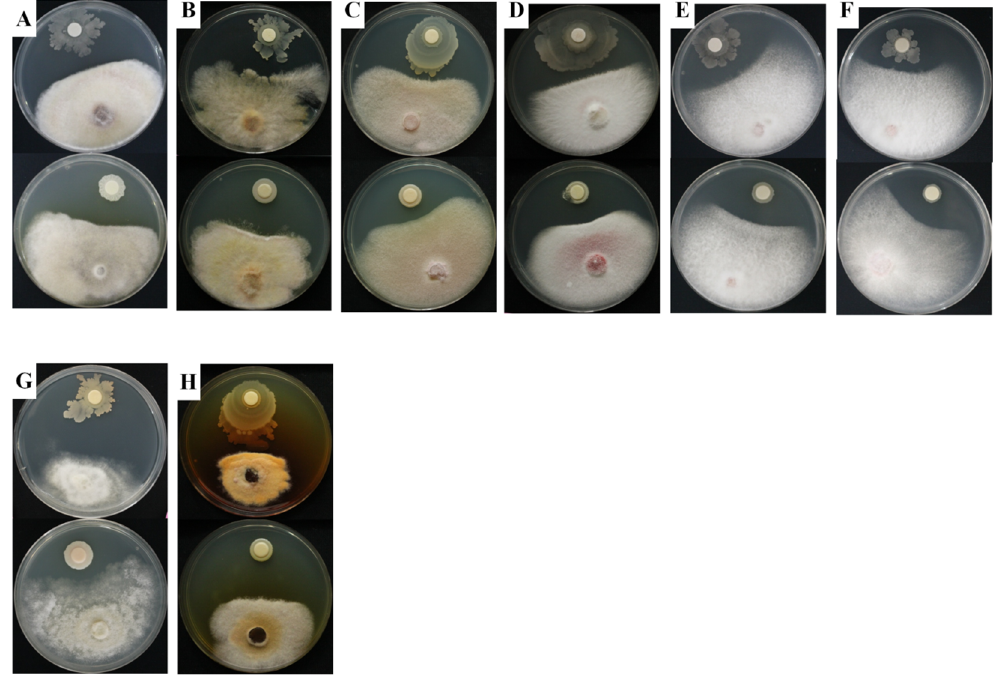
Figure 5. In vitro antifungal activity of the isolated Burkholederia strains against different phytopathogens in the dual culture: ( A ) A. alternate , ( B ) F. graminearum , ( C ) F. moniliforme , ( D ) F. ( D ) F. oxysporum f.sp. melonis , ( E ) F. subglutinans, ( F ) F. temperatum , ( G ) P. drechsleri , and ( H ) S. lycopersici oxysporum f.sp. melonis , ( E ) F. subglutinans , ( F ) F. temperatum, ( G ) P. drechsleri , and ( H ) S. lycopersici (top = B. cenocepacia strain KNUBI2, bottom = B. contaminans strain (top = B. cenocepacia strain KNUBI2, bottom = B. contaminans strain KNUBI3).